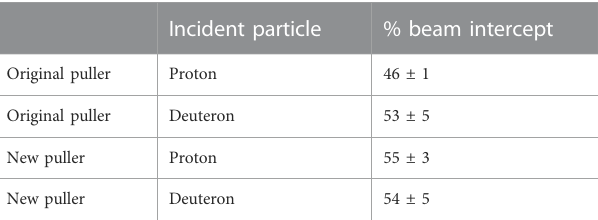
TABLE 5 Measured beam intercepts for the proton and deuteron beams.